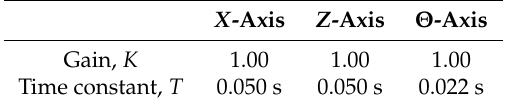
Table 2. Identified model parameters for the drive systems of the X -, Z -, and Θ -axes.